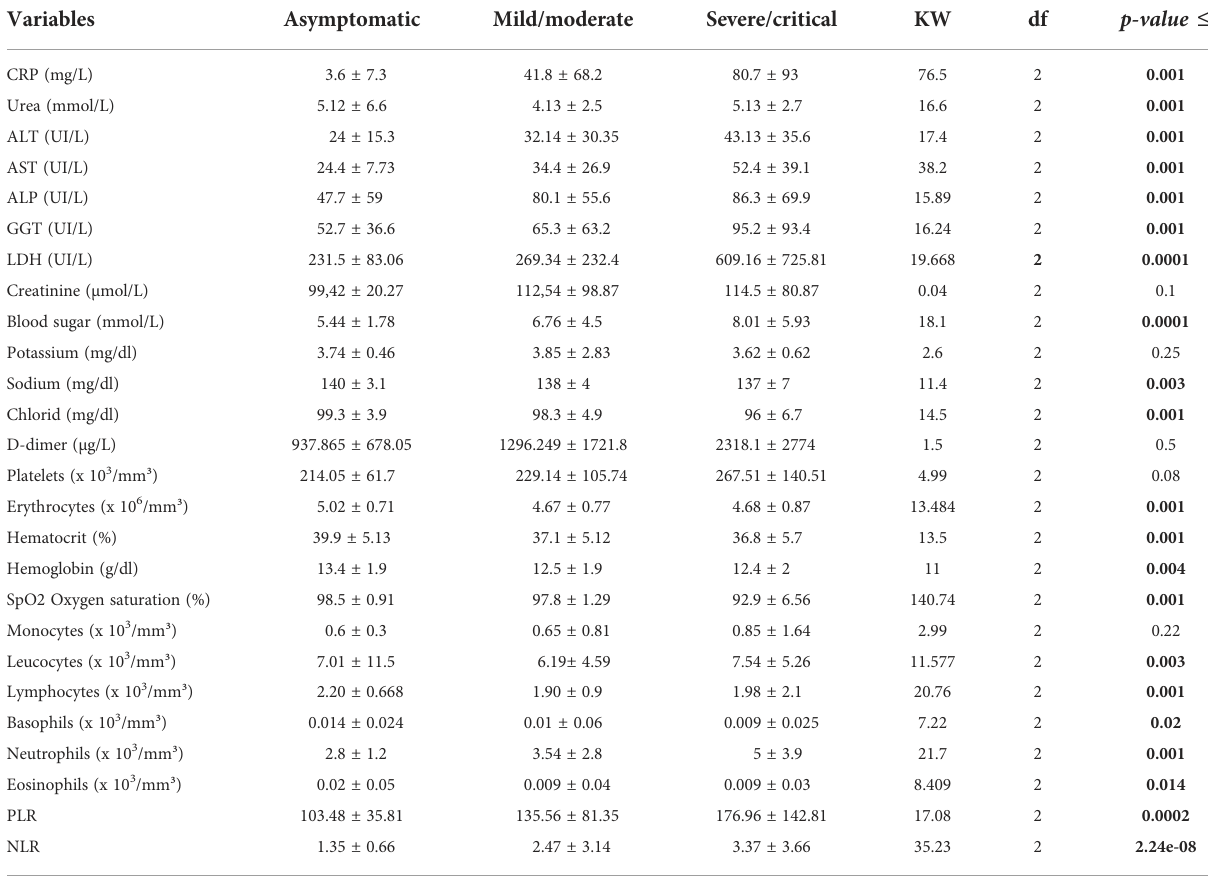
TABLE 2 Biochemical and hematological parameters according to COVID-19 severity in Gabonese